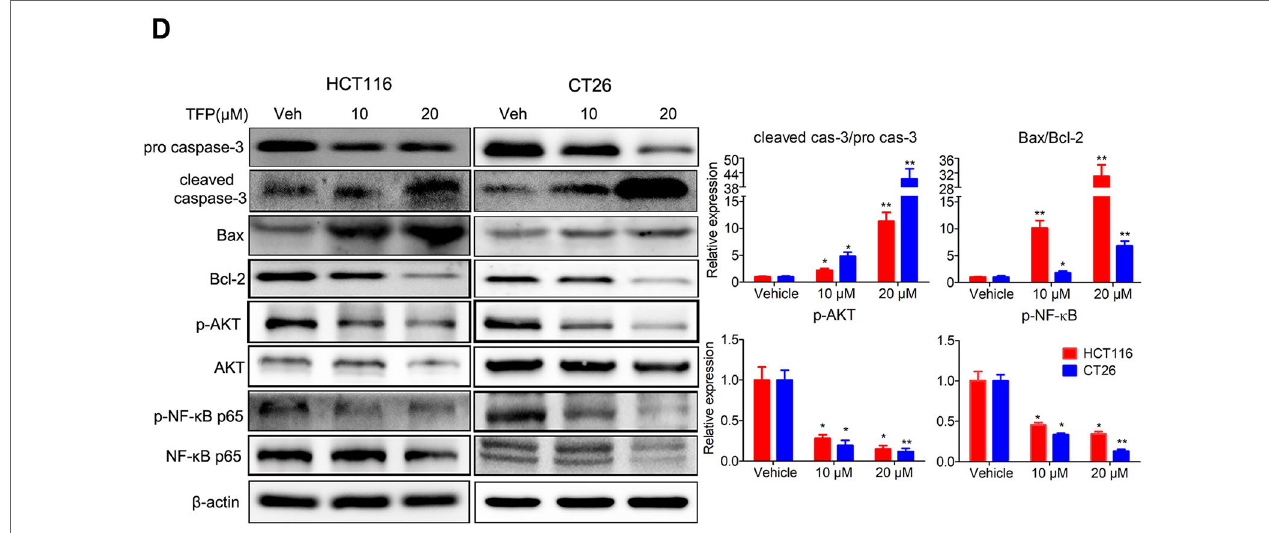
FIGURE 4 | Effects of TFP on apoptosis in HCT116 and CT26 cells. (A) TFP treatment induced accumulation of sub-G1 cells in HCT116 and CT26 cells. The cells were treated with 15 µM TFP for 24 or 48 h and then stained with PI after fixing with 75% ethanol. The proportion of sub-G1 cells in each group was analyzed with FCM. (B) Fluorescence microscopy analysis of Hoechst 33342-stained HCT116 and CT26 cells after incubation with TFP for 24 h. The arrows indicate nuclear fragmentation. The scale bars represent 20 µm for both cell lines. (C) FCM analysis of cells stained with Annexin V-FITC/PI after treatment with TFP for 48 h. Quantification values are shown to the right of each cell line. (D) Expression levels of critical apoptosis-related proteins after TFP treatment for 48 h. Quantification of the expression levels is shown on the right. *P < 0.05, **P < 0.01.